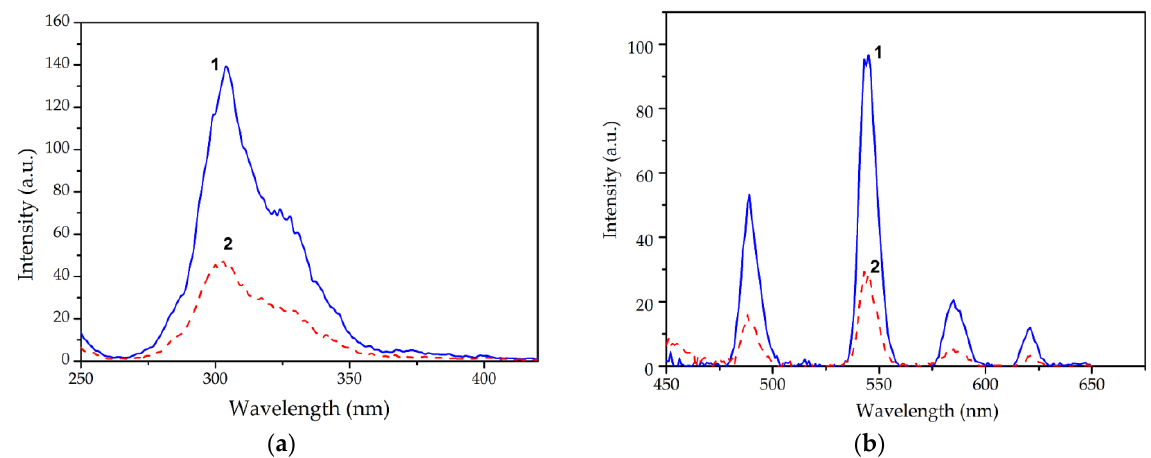
Figure 2. ( a ) Excitation spectra; ( b ) Fluorescence spectra of systems: 1. Tb(Phen), 2. Tb(Phen)-AA, С AA = 1.4 × 10 − 4 mol·L − 1 .